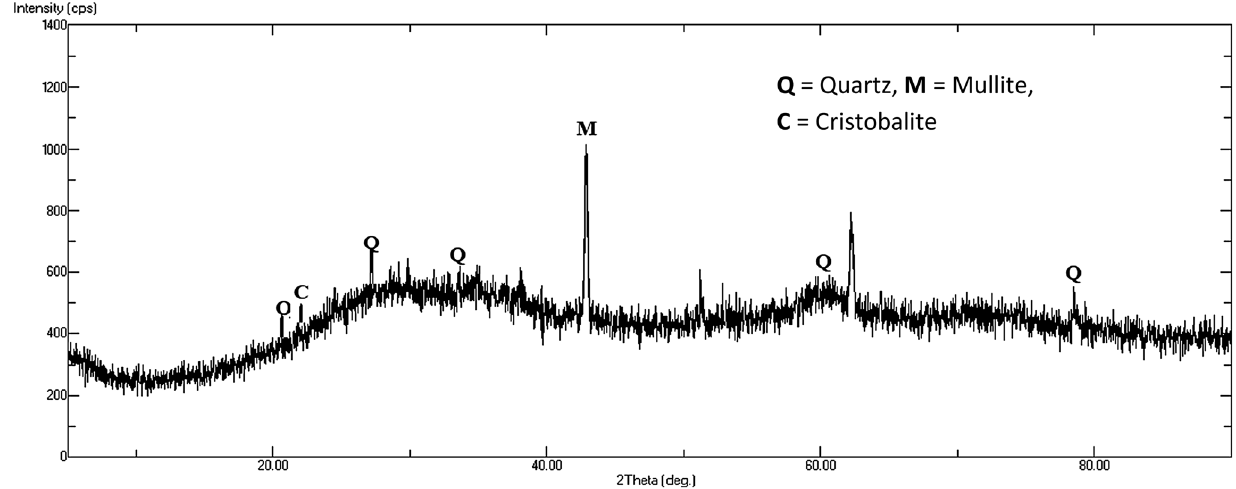
Fig. 5 PXRD spectrum of BFA showing constituent mineral